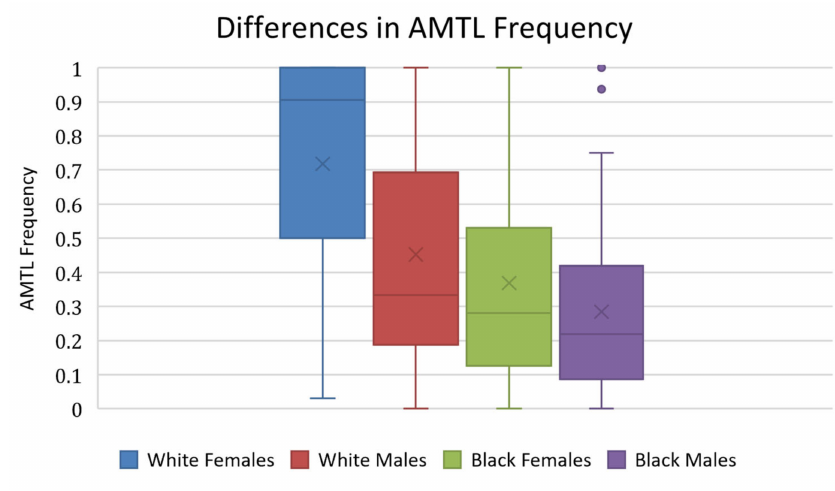
Figure 8. Differences in AMTL frequency among sub-populations. Table 5. AMTL presence and frequency.